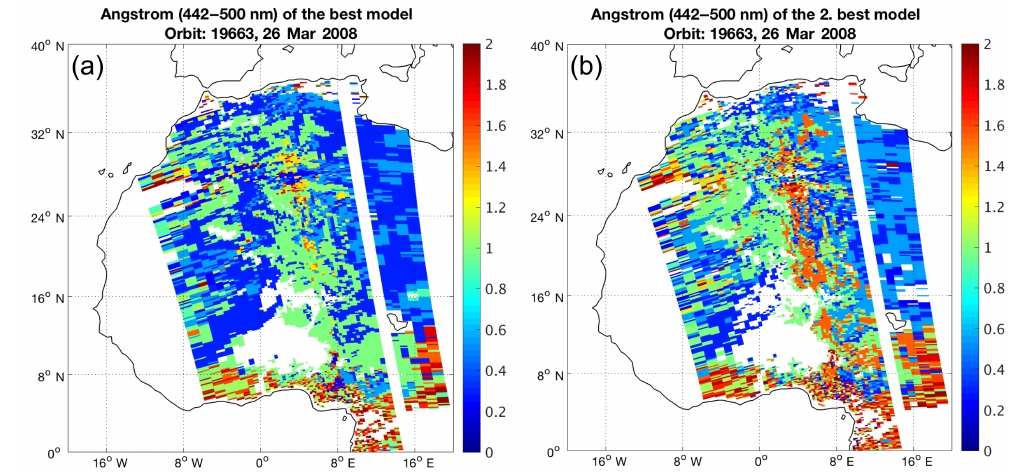
Figure 13. The Ångström exponent at 442–500nm of the ranked best (a) and the second-best (b) aerosol microphysical